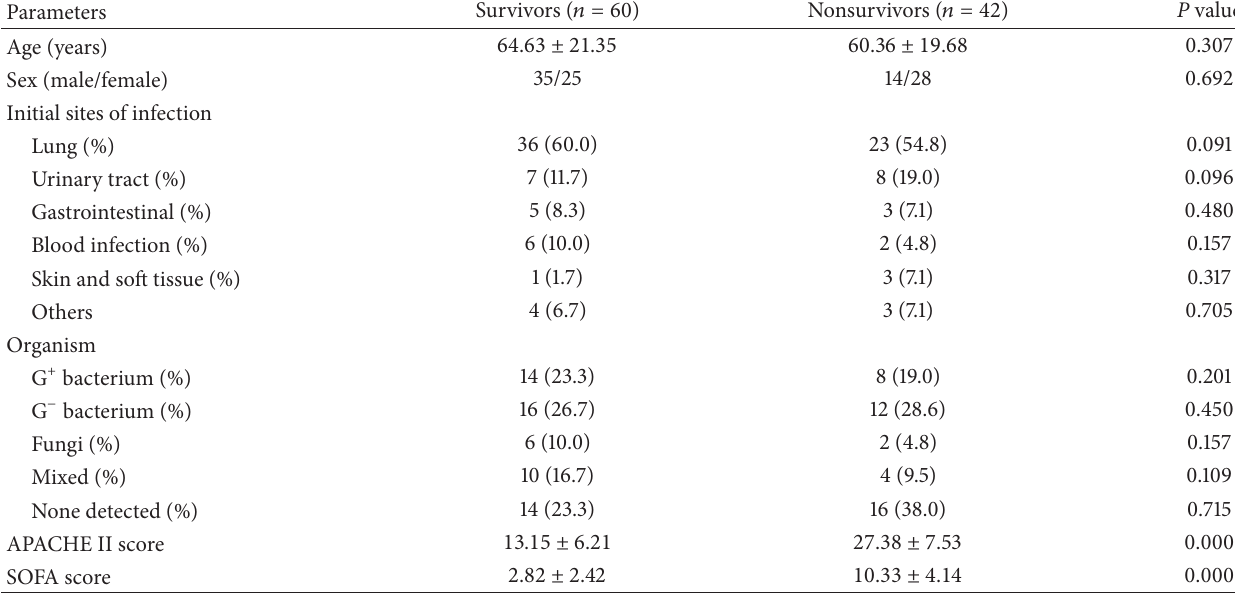
Table 1: Clinical characteristics of patients on admission to ICU.